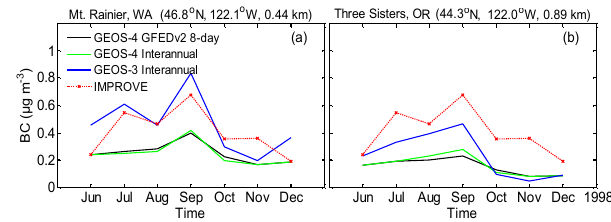
Figure 7. Planetary boundary layer heights for (left) August and (right) September 1998 at Mt. Rainier, WA (46.8°N, 122.1°W, 0.44 km) (black line, GEOS-4; green line, Fig. 7. Planetary boundary layer heights for (left) August and (right) GEOS-3; red line, North American Regional Reanalysis (NARR; available at September 1998 at Mt. Rainier, WA (46.8 ◦ N, 122.1 ◦ W, 0.44km) http://www.esrl.noaa.gov/psd/cgi-bin/data/narr/plothour.pl)). Values are for 14:00 local (black line, GEOS-4; green line, GEOS-3; red line, North American time (Daylight savings time). Regional Reanalysis (NARR; available at http://www.esrl.noaa.gov/ psd/cgi-bin/data/narr/plothour.pl). Values are for 14:00 LT (Day- light savings time).